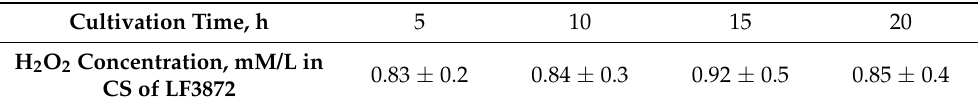
Table 9. Hydrogen peroxide in the process of LF3872 strain cultivation in the MRS broth. Cultivation Time,